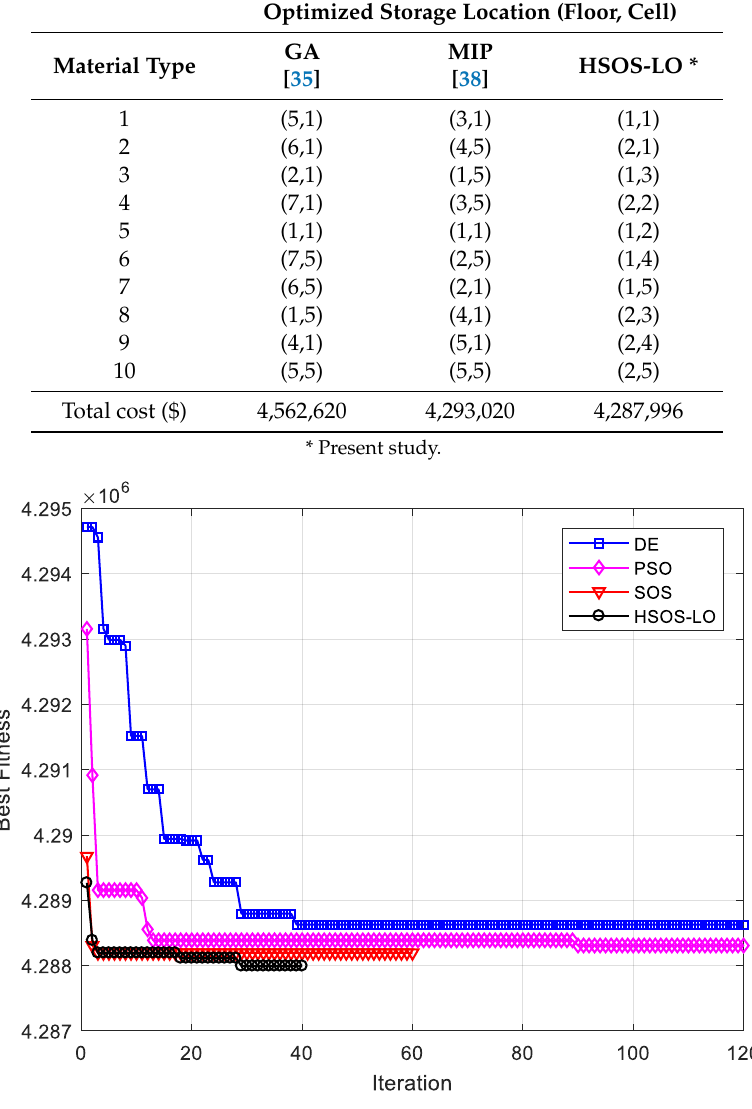
Figure 7. Convergence graphic of metaheuristic algorithms for Case 2.